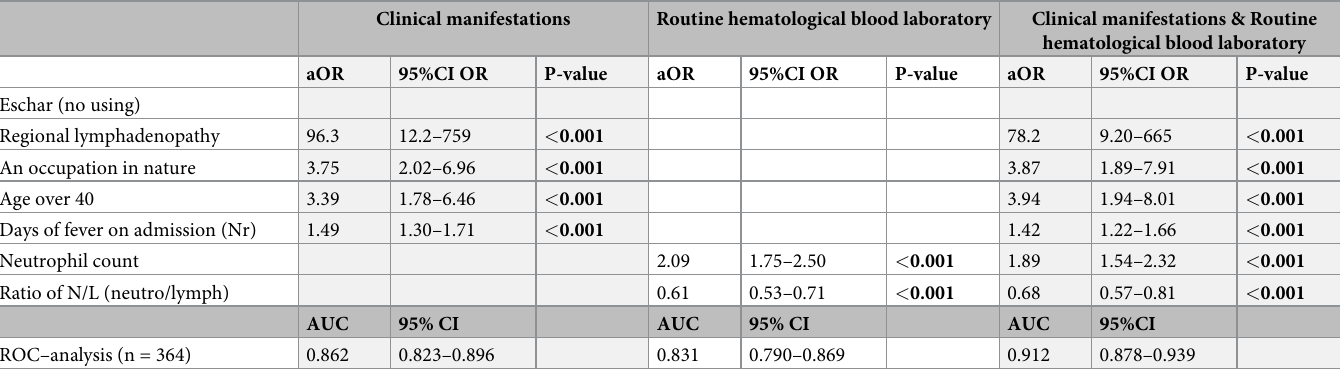
Table 2. Results from multivariate logistic regression with the most relevant predictors for the presence of scrub typhus (training part) #